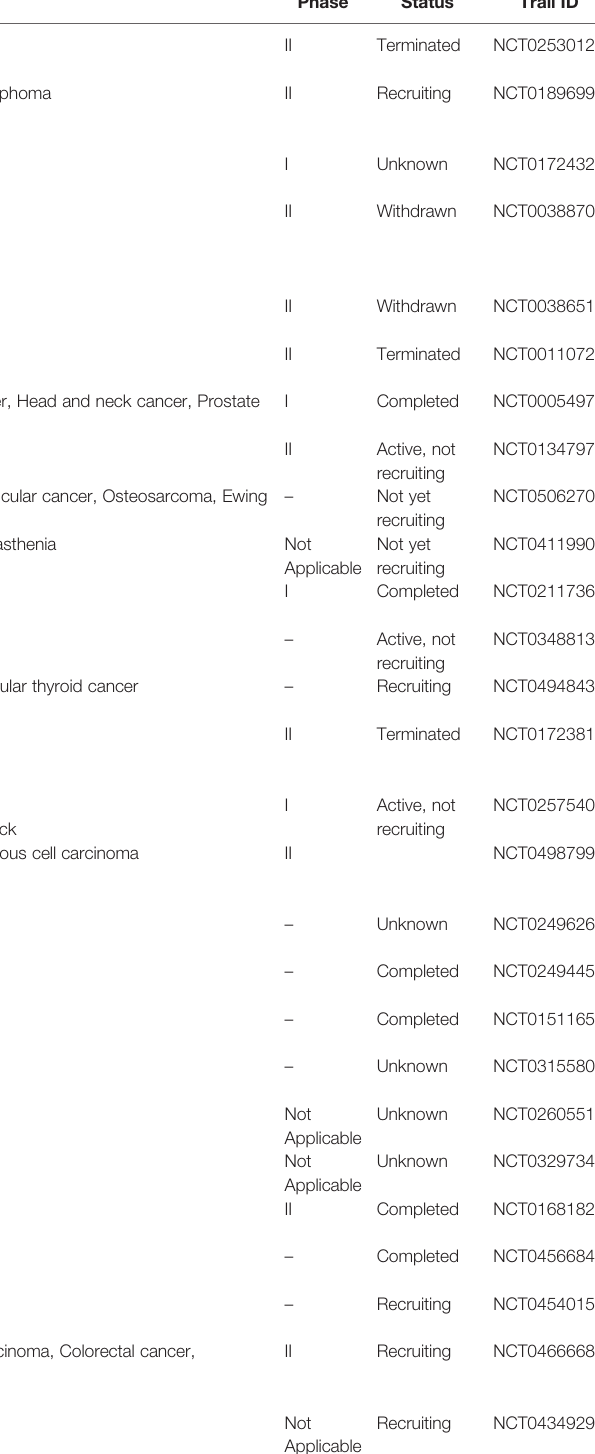
TABLE 2 | The tumor-related clinical trials targeting on galectin family molecules.